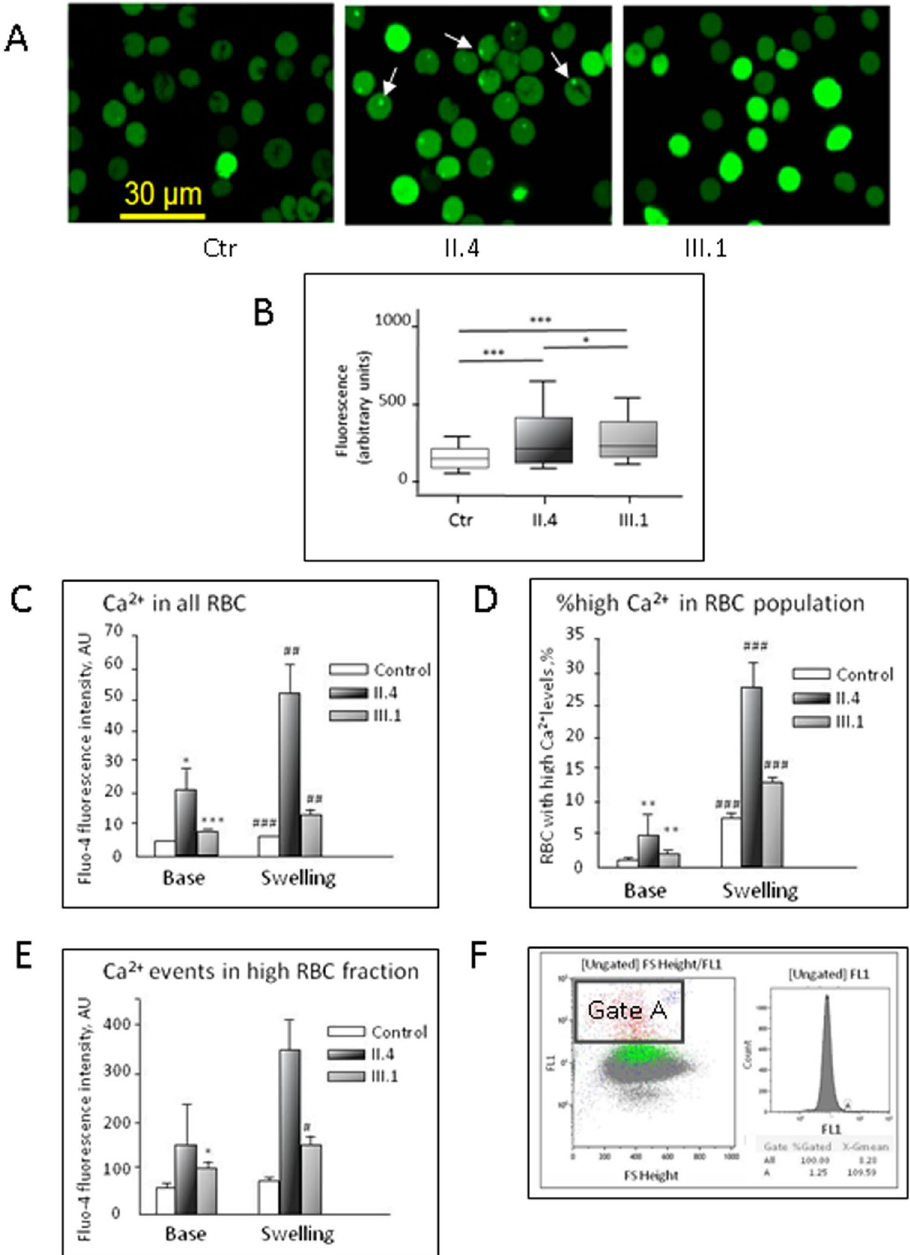
Figure 6. Calcium handling in patients with mutated Gardos channel. ( A ) Representative confocal images of RBCs from controls and the patients loaded with the Ca 2 + -sensitive dye Fluo-4. A brighter fluorescence corresponds to a higher Ca 2 + -concentration. White arrows indicate sequestration of Ca 2 + in intracellular vescicles. ( B ) Statistical analysis of wide field fluorescence Fluo-4 recordings for healthy donors (white bar, n = 2495 cells), patient II.4 (black shaded bar, n = 1257 cells) and patient III.1 (grey bar, n = 1402 cells). Because values are not Gaussian distributed we plotted boxes with whiskers from the 10 th to 90 th percentile. Significance was checked using the Mann-Whitney test; * , *** denote p < 0.05, and 0.001 respectively. ( C – F ) Intracellular Ca 2 + (assessed as Ca 2 + -dependent fluorescence of Fluo-4) in RBCs of healthy controls and patients II.4 and III.1 measured by flow cytometry. Intracellular Ca 2 + was measured at baseline and then the measurements were repeated immediately after the initiation of osmotic swelling by adding a bolus of distilled water to dilute the RBC suspension in isosmotic buffer by 1/3 (Swelling). ( C ) Readout for all RBCs in suspension; ( D ) Amount of cells forming “high Ca 2 + fraction” (A-gated fraction, flow cytometric analysis shown in panel (E); ( F ) fluorescence intensity of Fluo-4 in this “high Ca 2 + fraction”. All the experiments were performed in two occasions, and each time triple measurements were performed for each conditions. * , ** and *** denote p < 0.05, 0.01 and 0.001 respectively compared to healthy control. # , ## and ### stand for p < 0.05, 0.01 and 0.001 for osmotically compromised cells compared to the baseline values in either control or